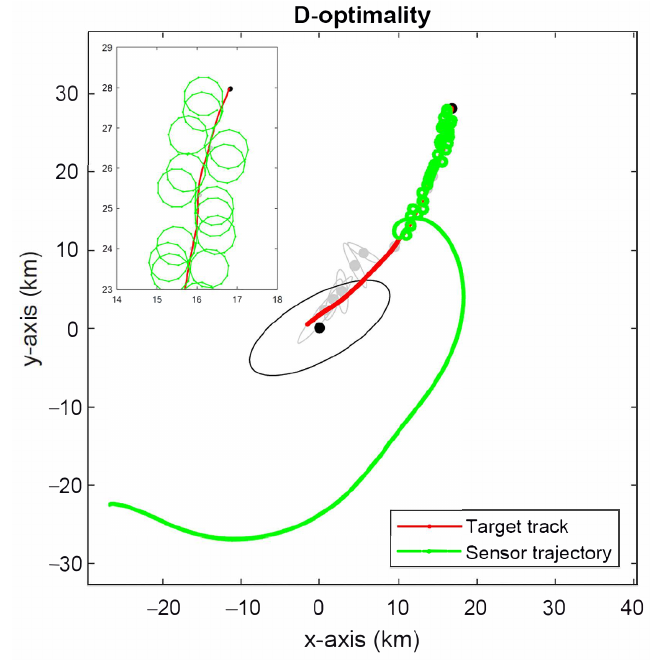
Figure 9. Optimal sensor trajectory for D-optimality criterion.